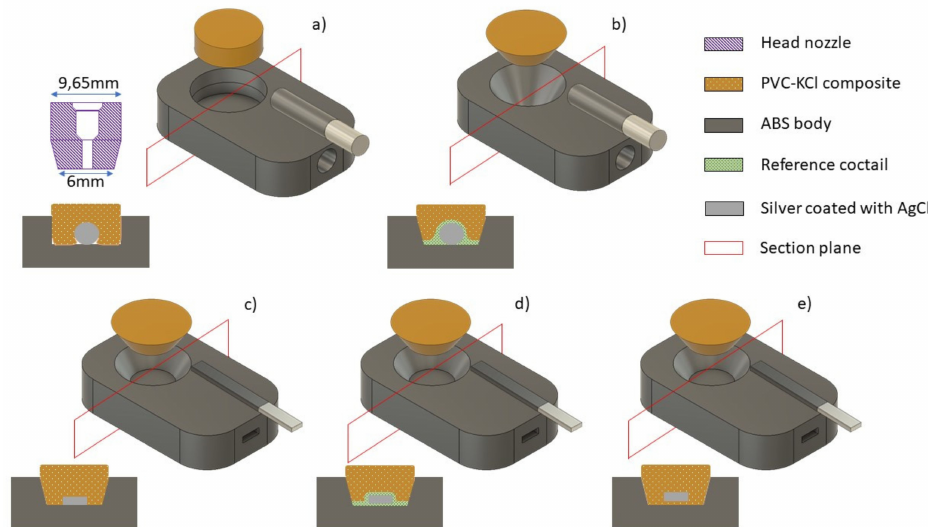
Figure 1. Sources in 3D fabrication deficiencies and their removal: ( a , c )—the Ag/AgCl rod ( a ) or tape ( c ) was inserted into the pre-printed hole, and the cylindrical ( a ) or conical ( c ) crater was filled with PVC-KCl composite. ( b , d )—some of the reference cocktail was placed in the crater, and the Ag/AgCl rod ( b ) or tape ( d ) was inserted into the pre-printed hole. After solvent evaporation, the crater was filled with PVC-KCl composite ( e )—the conical crater was filled with PVC-KCl composite. The Ag/AgCl tape was immediately inserted into the hot unhardened plastic composite. In the upper left corner: the lower part of the nozzle (neck diameter 2 mm). Crosscuts made by selection planes visualize the shape of the crater, solid contact, and its position in the